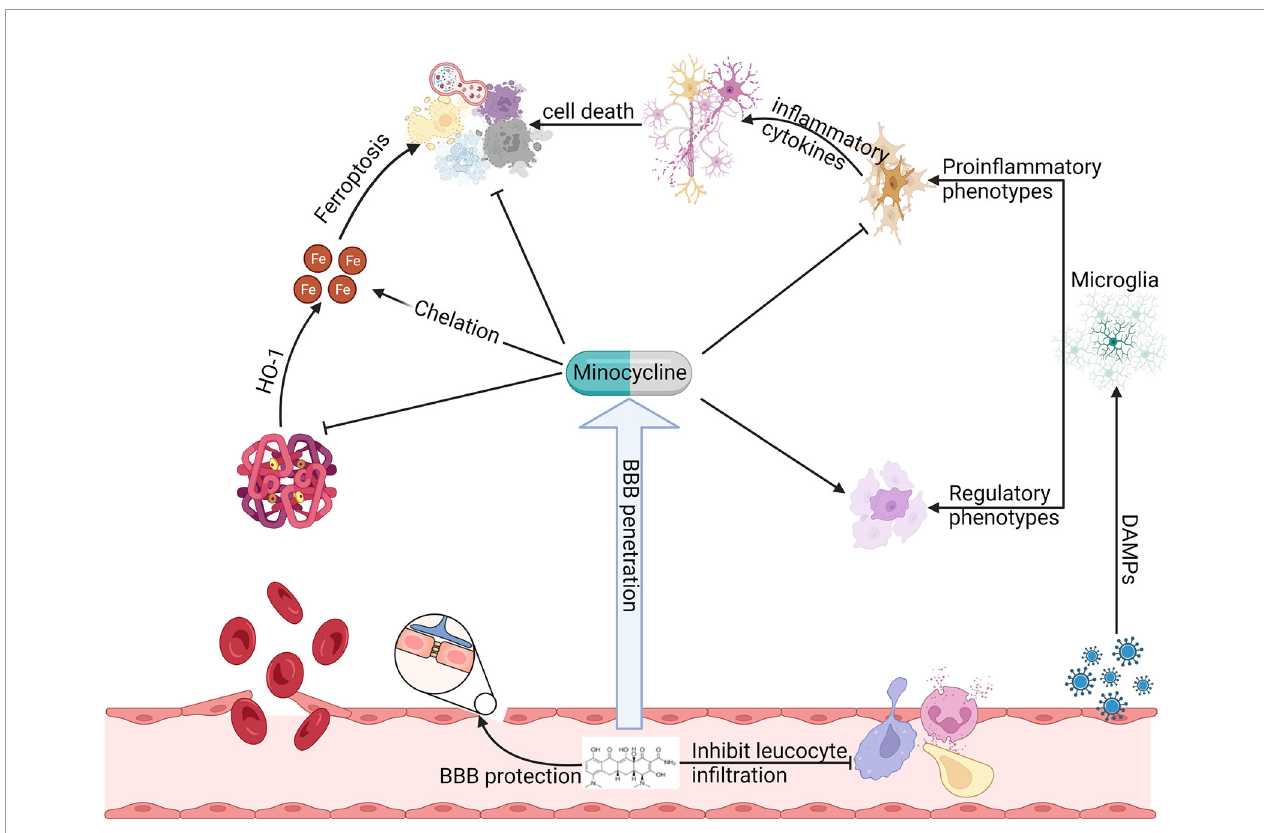
FIGURE 1 | Preclinical studies have observed that minocycline can function at multiple steps of ICH induced secondary brain injury to produce neuroprotection. Minocycline inhibits HO-1 activity, chelates iron, alleviates oxidative stress, reduces various types of cell death, preserves BBB integrity, regulates leukocyte function, and inhibits proin fl ammatory microglia while promoting its regulatory